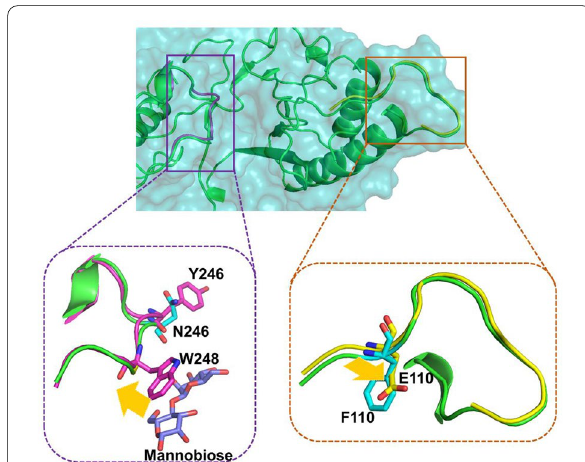
Fig. 7 Ribbon representations of the MD‑derived structures of PcMan113‑WT and PcMT3 with substrate: a overall structural overlap of WT and PcMT3; b enlarged view of the loop R243‑N255 (in color of magenta) in WT and MT3, and c enlarged view of the loop F110‑E118 (in yellow) in WT and PcMT3. PcMan113‑WT is shown in green and cyan, respectively. Mannobiose is shown as light blue